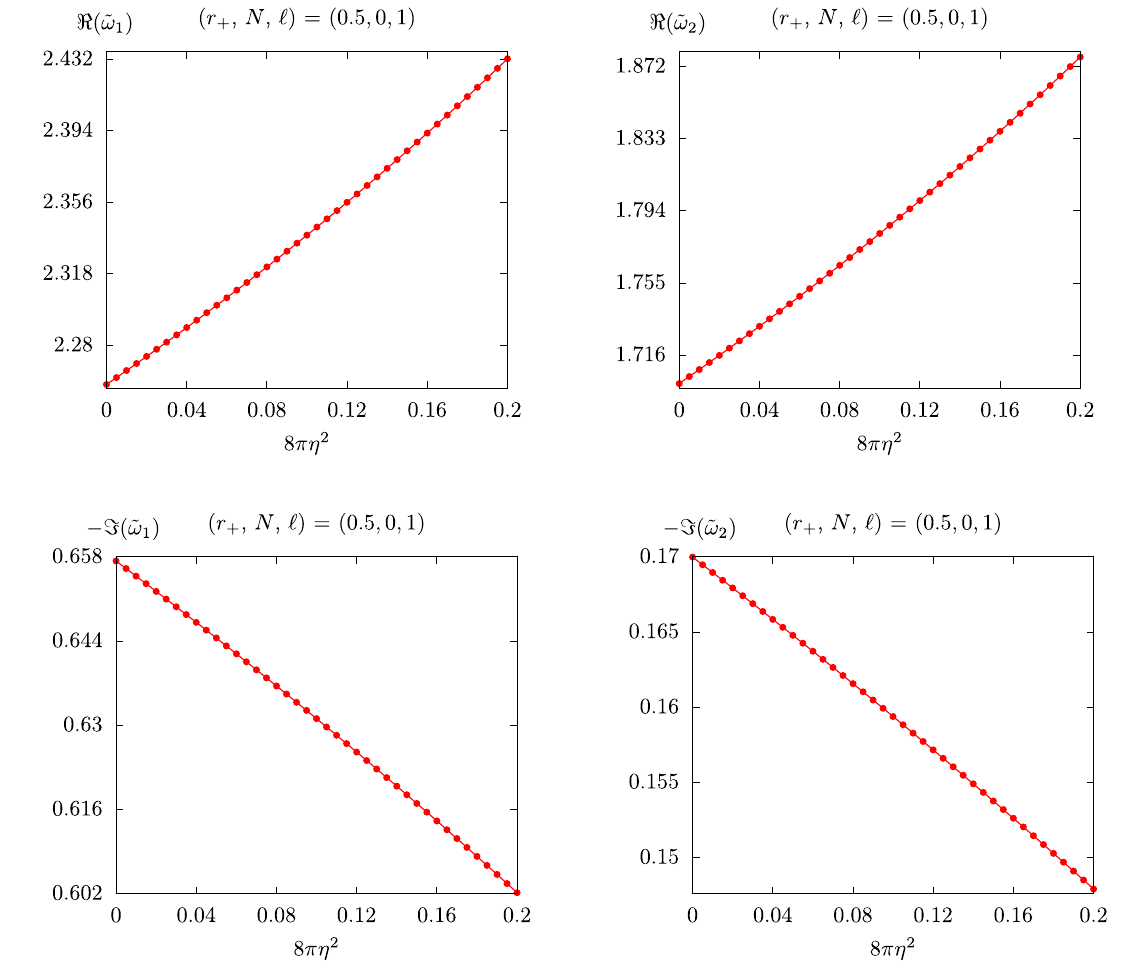
Fig. 3 The monopole effects on the real (top) and imaginary (bottom) part of quasinormal spectrum with the first (left) and second (right) boundary conditions, by taking r + = 0 . 5, (cid:2) = 1 and N = 0 as an illustrative example. The similar behaviors are also observed for other values of r + , (cid:2) and N ˜ L of